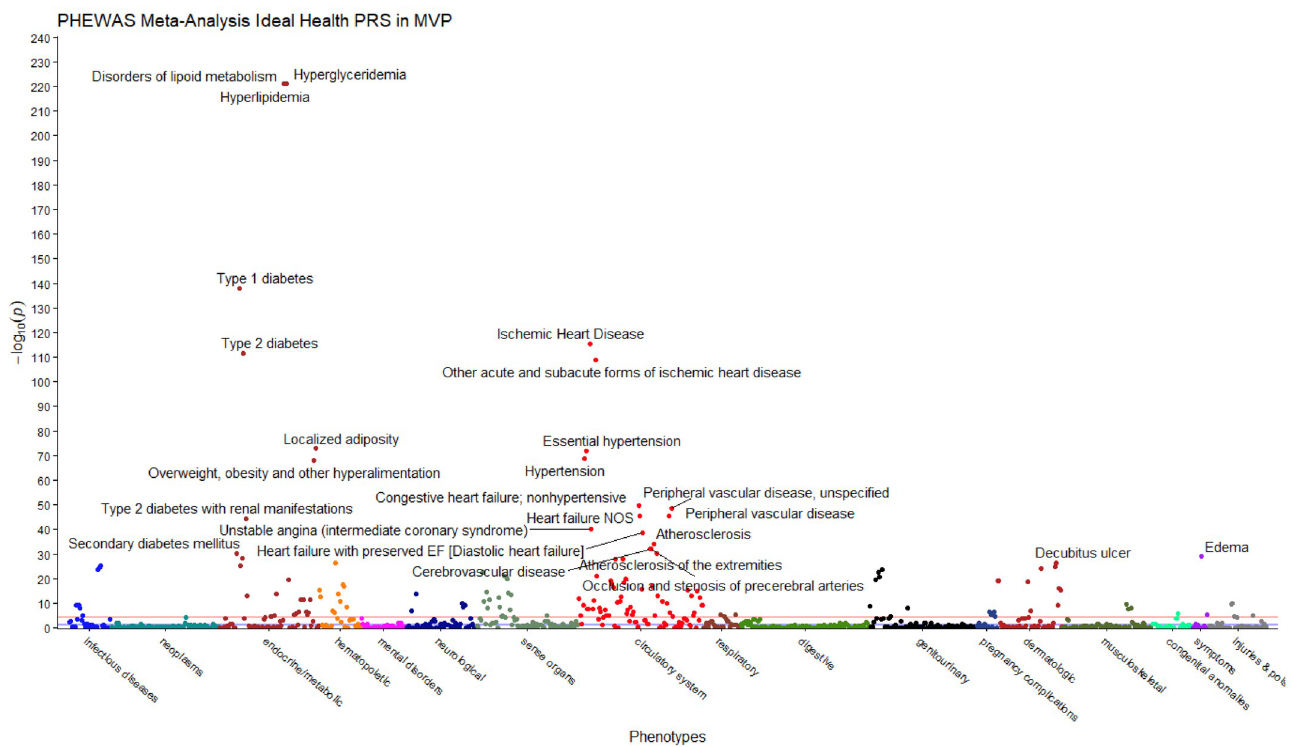
Fig 2. Multi-population PheWAS Manhattan plot: Ideal health score polygenic risk score vs disease phecode. The negative log of the p-value is plotted for each of 882 disease phenotypes or “phecodes” with at least 200 cases and 200 controls in MVP. The horizontal red line indicates the statistically significant threshold (P < 5.67 × 10 − 5 ). Each color represents a disease category as defined on the x-axis. Loci achieving p < 1 × 10 − 30 are annotated with the phecode